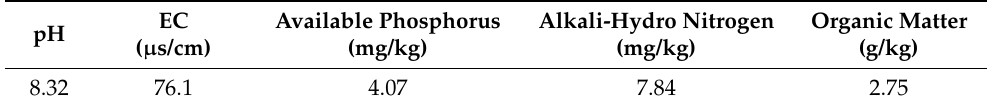
Table 1. Basic physical and chemical properties of soil.